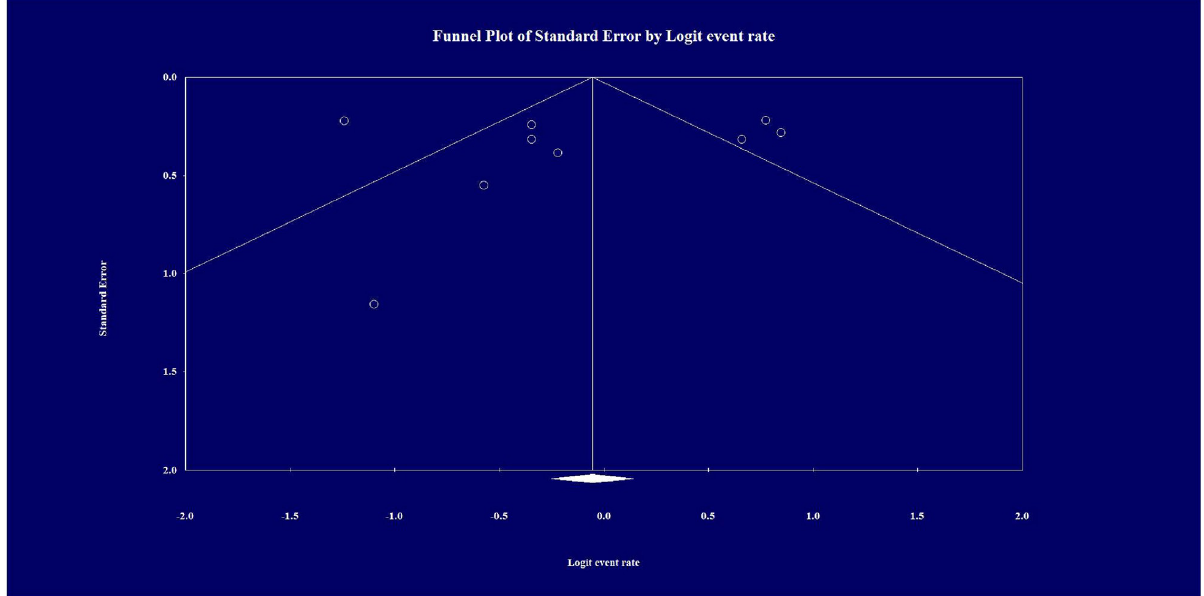
Fig 5. Funnel plot of standard error by Hedges for trials included in the meta-analysis. The open circles in the figure represent observed studies. The diamond represents the observed effect size. The result of the Egger’s test of the intercept-indicated bias in the funnel plots was not statistically significant ( P = 0.867).